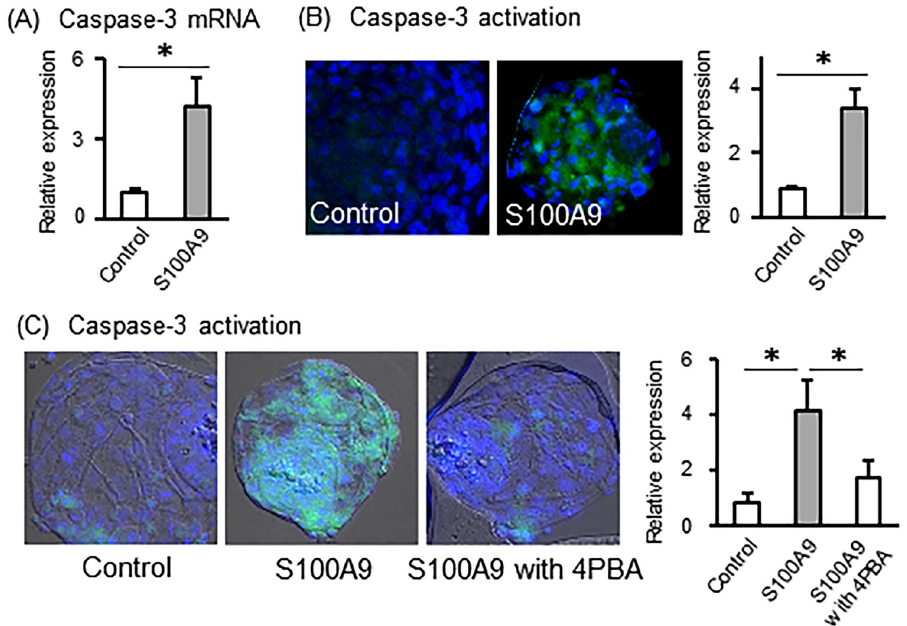
Fig 3. Effect of S100A9 exposure to blastocyst stage embryos on caspase-3 activation. Bovine blastocyst-stage embryos were treated with 0 and 4 μ g/ml of S100A9 concentrations for 24 h. (A) The mRNA expression of caspase-3 was determined (relative to ACTB mRNA levels). (B) Fluorescence microscopic image of active caspase-3 in embryos and calculated the relative fluorescence expression levels. (C) Blastocyst embryos were pretreated with ER stress inhibitor then treated with S100A9. Fluorescence microscopic image of active caspase-3 in embryos and calculated the relative fluorescence expression levels. All values are shown as mean ± SEM. ‘ � ’ indicates significant differences ( P <